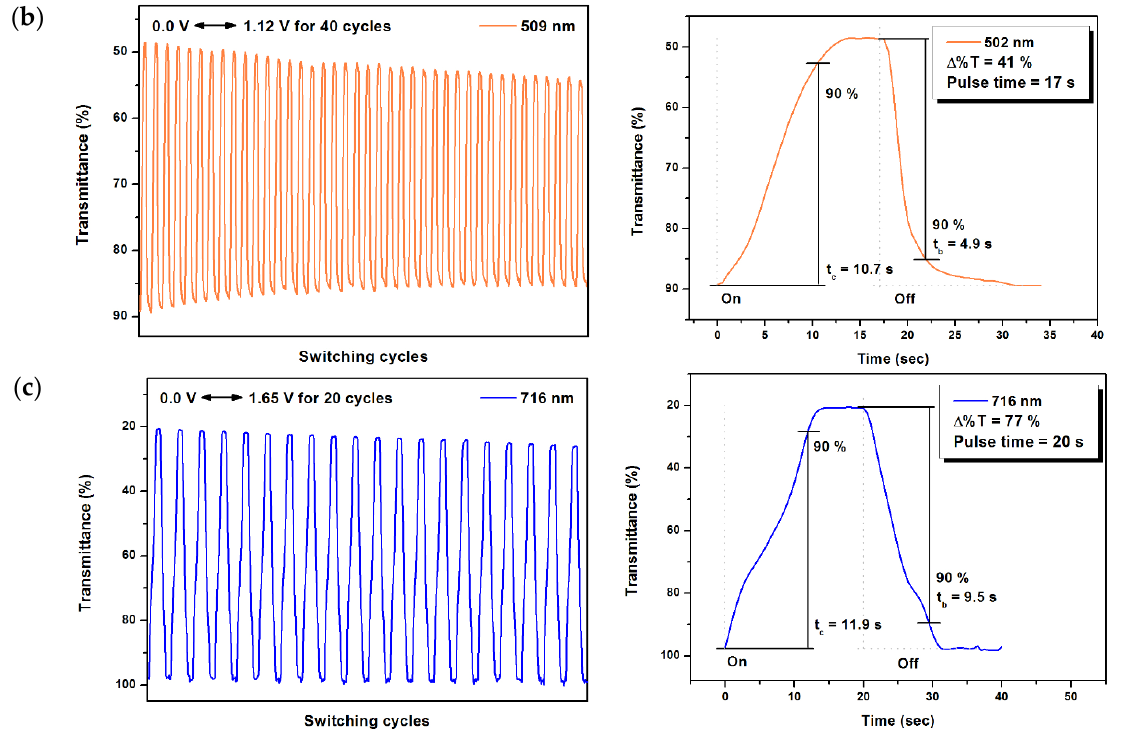
Figure 11. Percentage transmittance changes of the cast film of P1 on the ITO-glass slide (coated area ~1 cm 2 ) (in CH 2 Cl 2 with 0.1 M Bu 4 NClO 4 as the supporting electrolyte) by applying a potential at ( a ) 0.0 0.87 V for 50 cycles, ( b ) 0.0 1.12 V for 40 cycles, and ( c ) 0.0 1.65 V for 20 cycles.